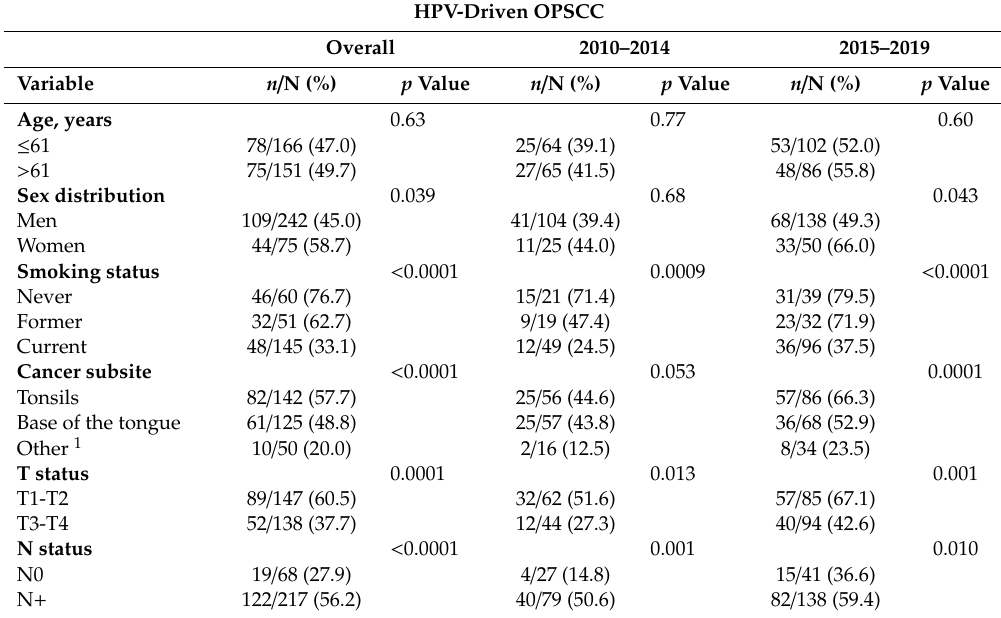
Table 3. Prevalence of HPV-driven oropharyngeal squamous cell carcinomas (OPSCC) according to selected variables, overall and according to the period of diagnosis.